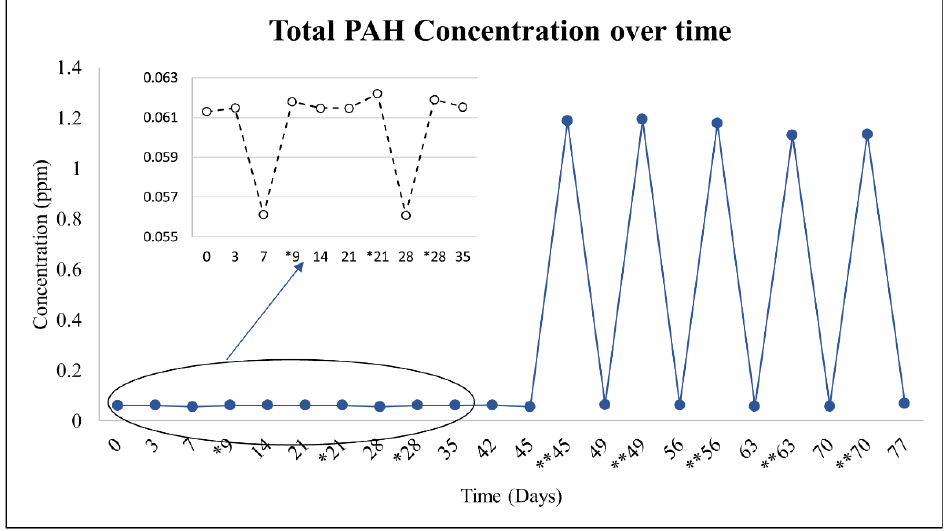
Figure 6. Concentration of the total GC-MS detected PAHs over the course of the experiment. * denotes the addition of oil and ** denotes the addition of oil and dispersant.